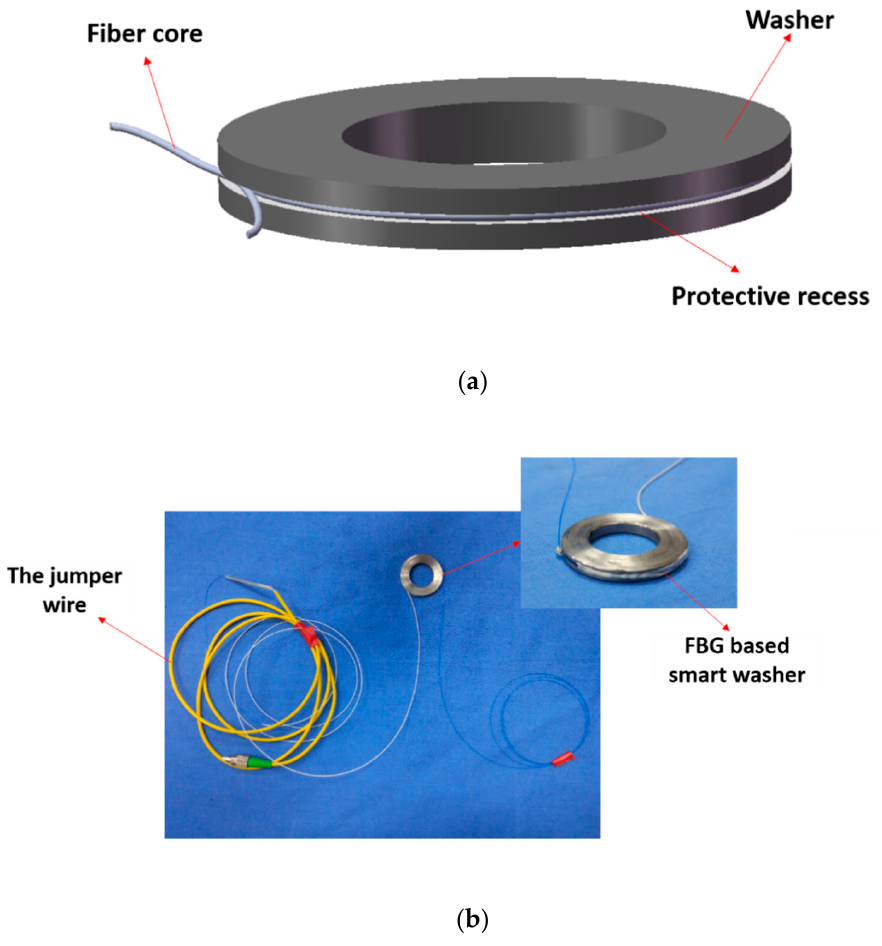
Figure 2. The FBG-enabled smart washer sensor. ( a ) The design diagram of the FBG-enabled smart washer; ( b ) Photos of the FBG-enabled smart washer.